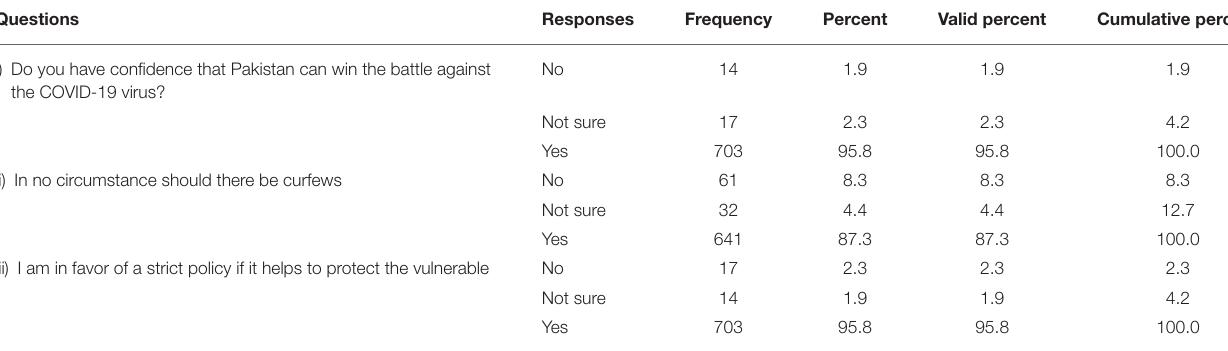
TABLE 6 | Attitudes toward COVID-19 ( N =